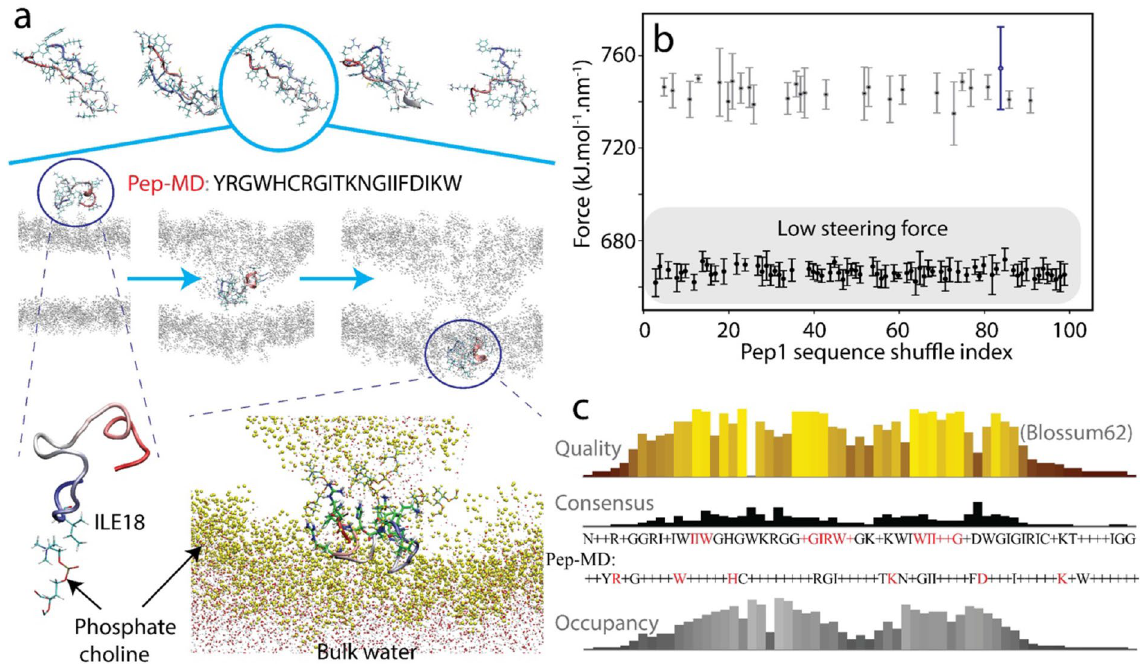
Figure 1. Atomic mechanism of the penetrating process of Pep-MD. ( a ) Snapshots from the penetration process. The top row: the five conformations of the peptides predicted by I-TASSER. The middle row: the penetration process. The gray dots illustrate lipid headgroups. The bottom row: the left image shows a closeup view of Pep-MD and a phosphate choline at the first contact; the right image shows the stage just before the escape from the membrane. Yellow dots represent the membrane headgroups while red (oxygen) and white (hydrogen) spheres represent water molecules. ( b ) Distribution of the maximum steering force of shuffled peptides. The blue dot and error bar indicate the largest steering force among them. ( c ) The results of the sequence alignment (quality, consensus and occupancy) among the peptides with low steering force by Blossum62. The sequence shown with the consensus indicates the alignment motif (the upper sequence), whose high consensus probability/occupancy residues are shown in red. The sequence of Pep-MD (the lower) is also shown; the residues shown in red match the consensus